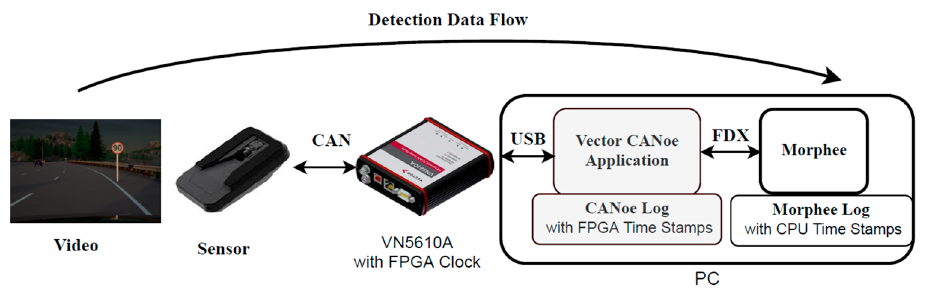
Figure 7. Sign detection data flow diagram.